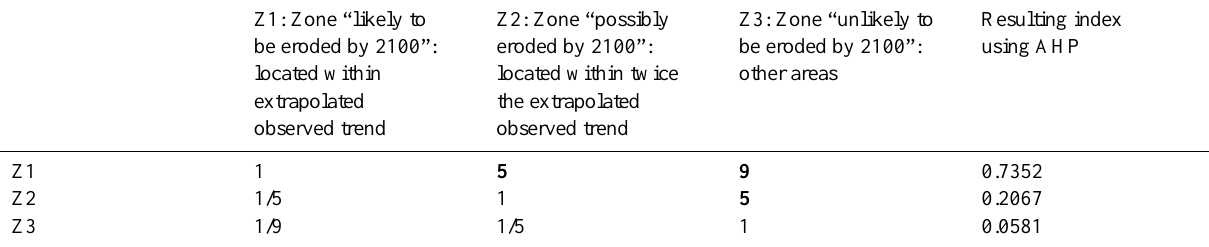
Table 2. Pairwise comparison of three zones with respect to their potential to be eroded in 2100 with a hypothesis of no sea level rise, following Saaty (2008a). The numerical values in the matrix are directly those from “Saaty’s scale” (Table 1). Experts filled the bold numerical values. For example, the numerical value “5” (line 1, column 2) indicates that the judgement strongly favours that Z1 is more likely to be eroded than Z2 in 2100. “9” in column 3 indicates that there is extreme evidence that Z3 is more likely to erode than Z1. The resulting index provides the final scores obtained for each zone (Z1, Z2, and Z3) with respect to the criterion “potential to be eroded in 2100”. It is calculated by “raising the pairwise comparison matrix to large powers, summing each row and dividing each by the total sum of all rows” (Saaty, 2008a, see Sect.